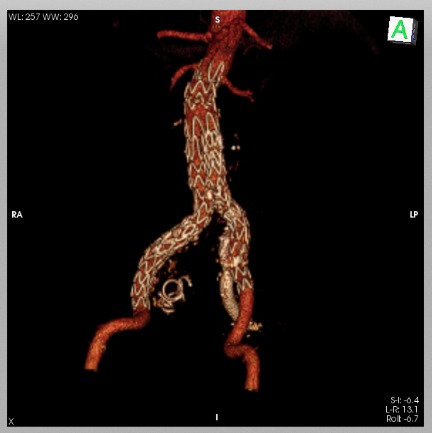
Control angiotomography in 3D reconstruction.